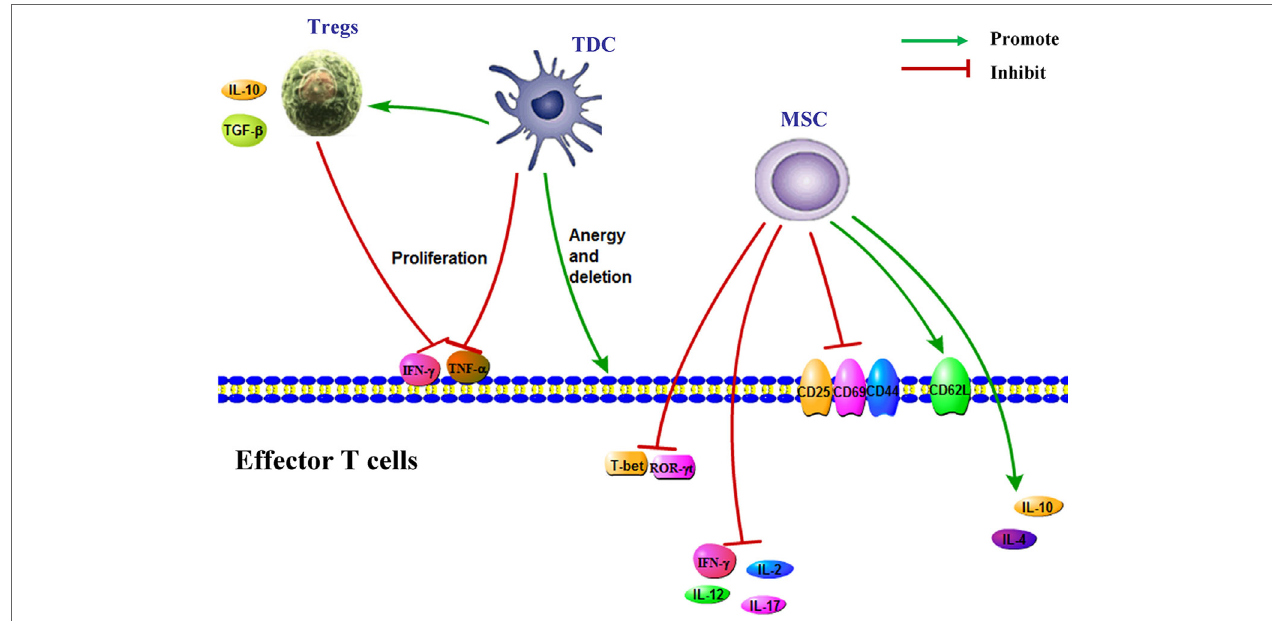
FiGURe 1 | Immune cells for the treatment of Graft-versus-host disease. Regulatory T cells (Tregs) secret IL-10 and TGF- β and inhibit effector T cell proliferation and the production of IFN- γ and TNF-alpha. TDCs have low expression of MHC and co-stimulatory molecules, express high levels of immunosuppressive cytokines, expand Foxp3 + Treg and suppress allo-CD4 + T cell proliferation, and induce the anergy and deletion of effector T cell. MSC induce the expression of CD62L and the production of IL-4 and IL-10 in T cell and inhibit the expressions of ROR- γ t, CD25, CD69, and CD44 and proinflammatory cytokines production. Abbreviations: MSC, mesenchymal stem cell; TDC, tolerogenic dendritic cells; Treg, regulatory T